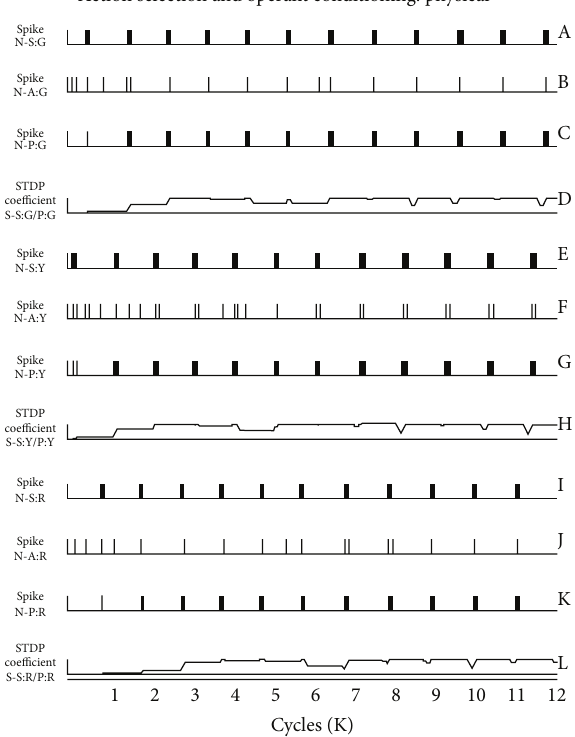
Figure 8: Graphics of the neural spikes and the STDP rule factors occurring over 12000